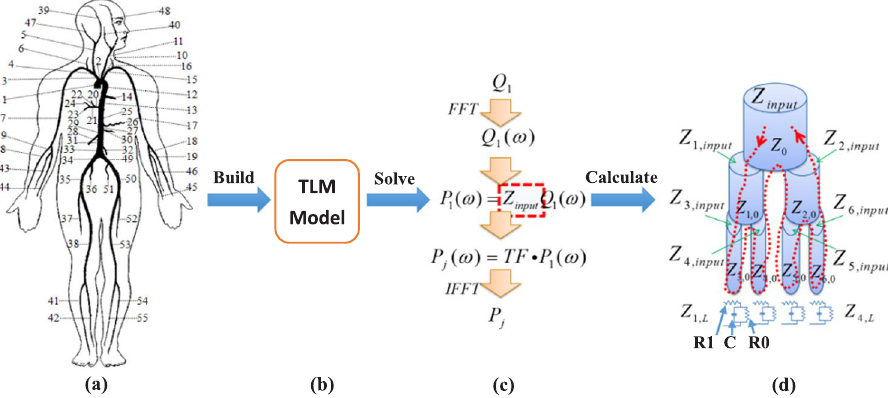
Figure 4. The schematic diagram of the model and solution: ( a ) the 55-segment model of human arterial tree, ( b ) TLM model, ( c ) solution strategy of the TLM model, and ( d ) calculation process of input impedance of a seven segment